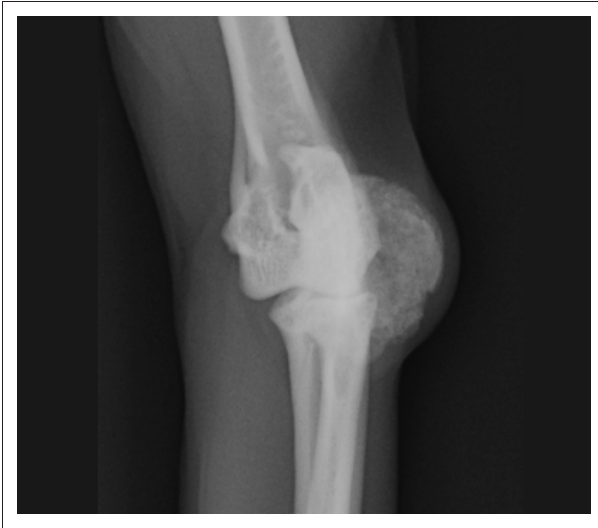
FIGURE 1: Craniocaudal view of the left elbow of a cat positive for feline leukaemia virus. Note the presence of an oval, well-circumscribed mineralised mass craniolateral to the elbow